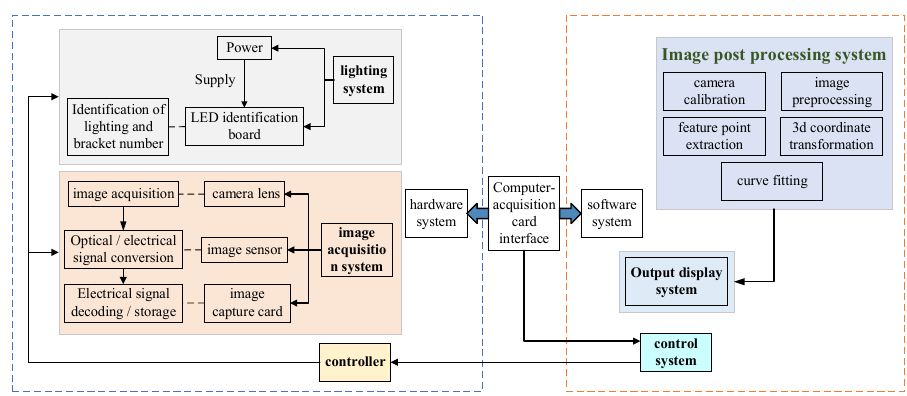
Figure 3. Visual measurement system with scraper conveyor straightness.